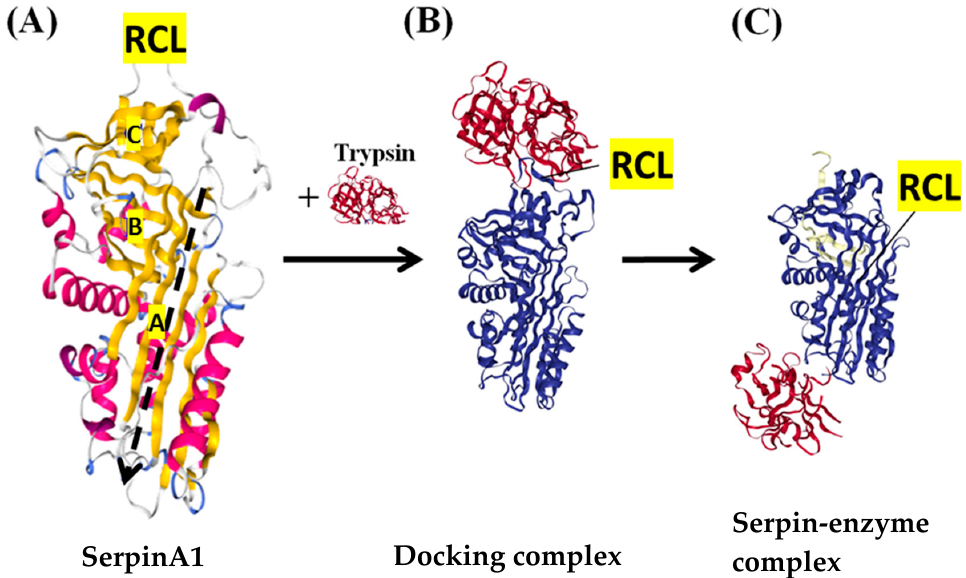
Figure 1. The structure and mechanism of inhibitory serpins. ( A ) The native structure of the archetypal serpin—serpinA1 (protein data bank (PDB) code 1QLP). The α -helices are shown in pink, and 3 β -sheets with gold color are marked with A, B and C. The reactive center loop (RCL) is at the top of the molecule and between A sheet and C sheet. The black dashed line indicates the path of RCL insertion after RCL is cleaved by the target protease. ( B ) The docking complex between serpinA1 (blue) and inactive trypsin (red) (PDB code 1OPH). The protease docked onto the RCL. ( C ) The final serpin–enzyme complex (PDB code 1EZX). After the RCL is cut, the serpin undergoes a transition from the stressed form to the relaxed form, and the docking complex becomes the serpin–enzyme complex, in which the distorted protease hangs at the base of the serpin molecule.